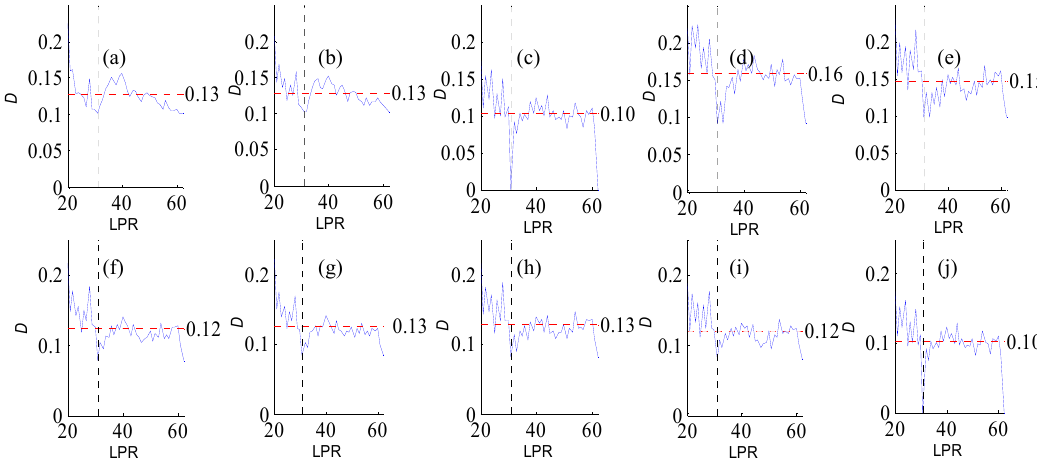
Figure A13. Variation of flow regime alteration degree (D) measured by the RVA with change in the length of pre-impact flow time series (LPR) under a periodicity of 31 years. ( a ), ( b ), ( c ), ( d ), ( e ), ( f ), ( g ), ( h ), ( i ), and ( j ) correspond to pre-impact flow time series length = 22, 27, 31, 35, 40, 44, 49, 53, 58, and 62 years, respectively. The abscissa value for the vertical dotted line is 31. The ordinate value for the horizontal dotted line is the mean degree of flow regime alteration in each subfigure.